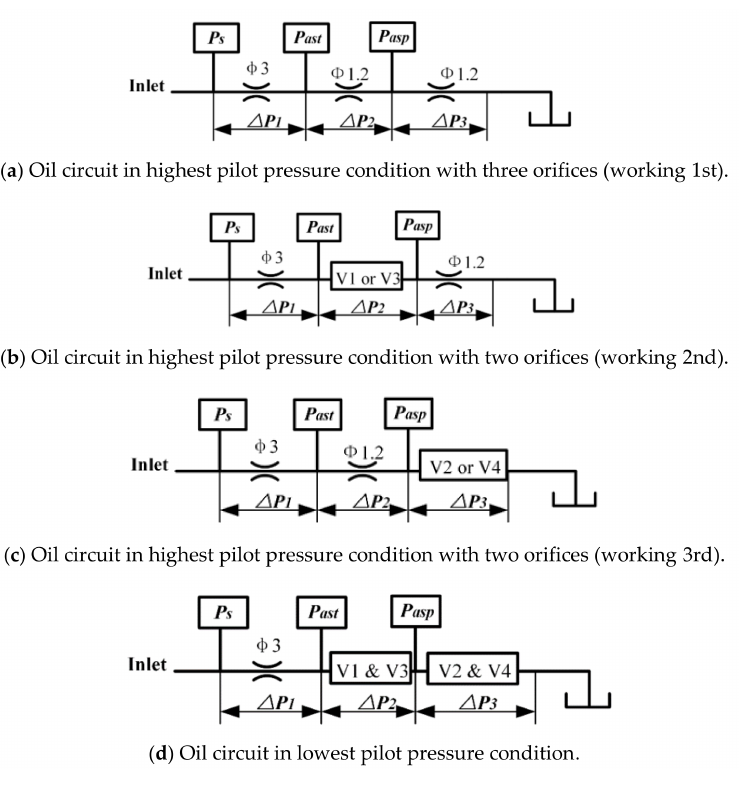
Figure 2. Two different levels of pilot control pressure circuit: ( a ) Oil circuit in highest pilot pressure condition with three orifices (working 1st); ( b ) Oil circuit in highest pilot pressure condition with two orifices (working 2nd); ( c ) Oil circuit in highest pilot pressure condition with two orifices (working 3rd); ( d ) Oil circuit in lowest pilot pressure